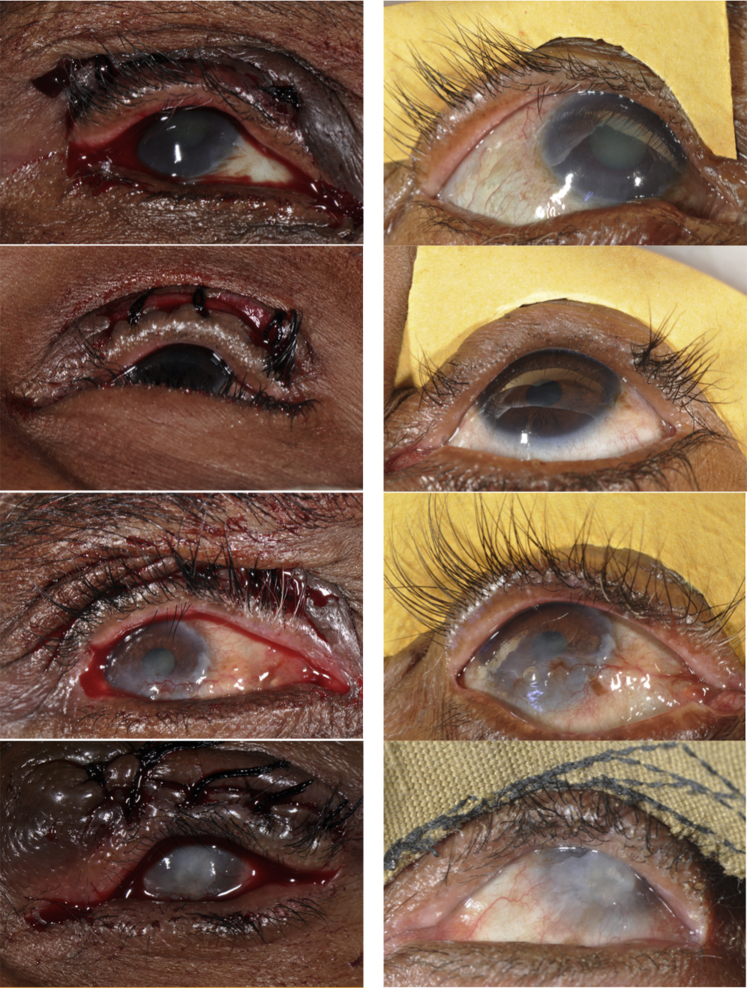
Immediate postoperative undercorrection. Left: Immediate postoperative pictures of patient with central undercorrection. Right: The 12-month follow-up pictures of the same eye showing postoperative trachomatous trichiasis (PTT) at the same area.